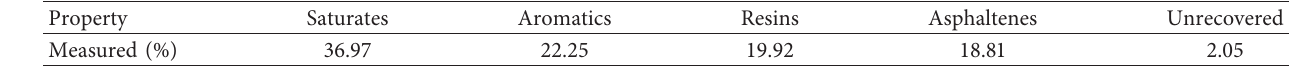
Table 1: SARA of the crude oil sample.